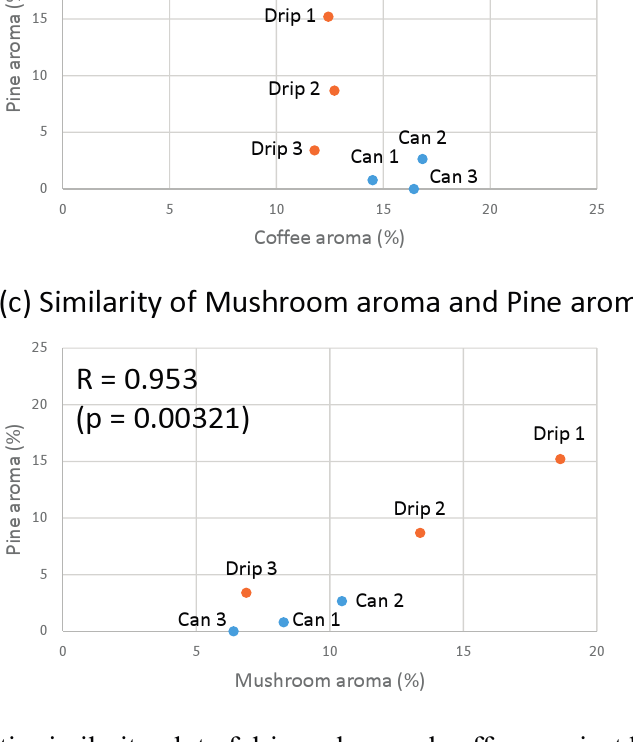
Figure 3. Aromatic similarity plot of drip and canned coffees against kit coffee, mushroom, and pine (average, n = 3). The similarity values of Canned 1–3 were obtained from a conference proceeding